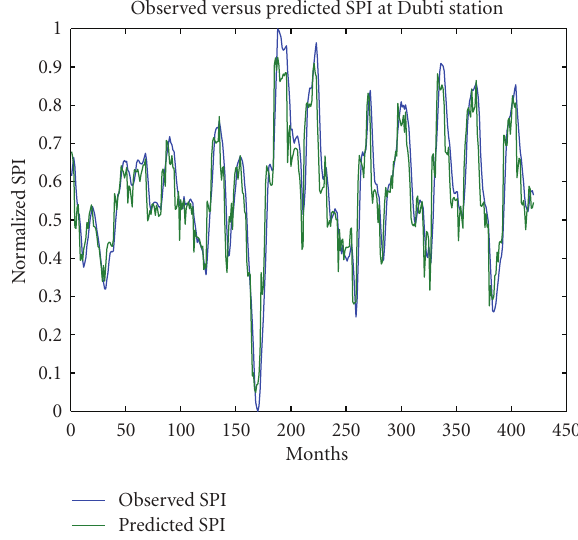
Figure 8: SPI 12 forecast results for the best WN model at the Dubti station (1-month lead